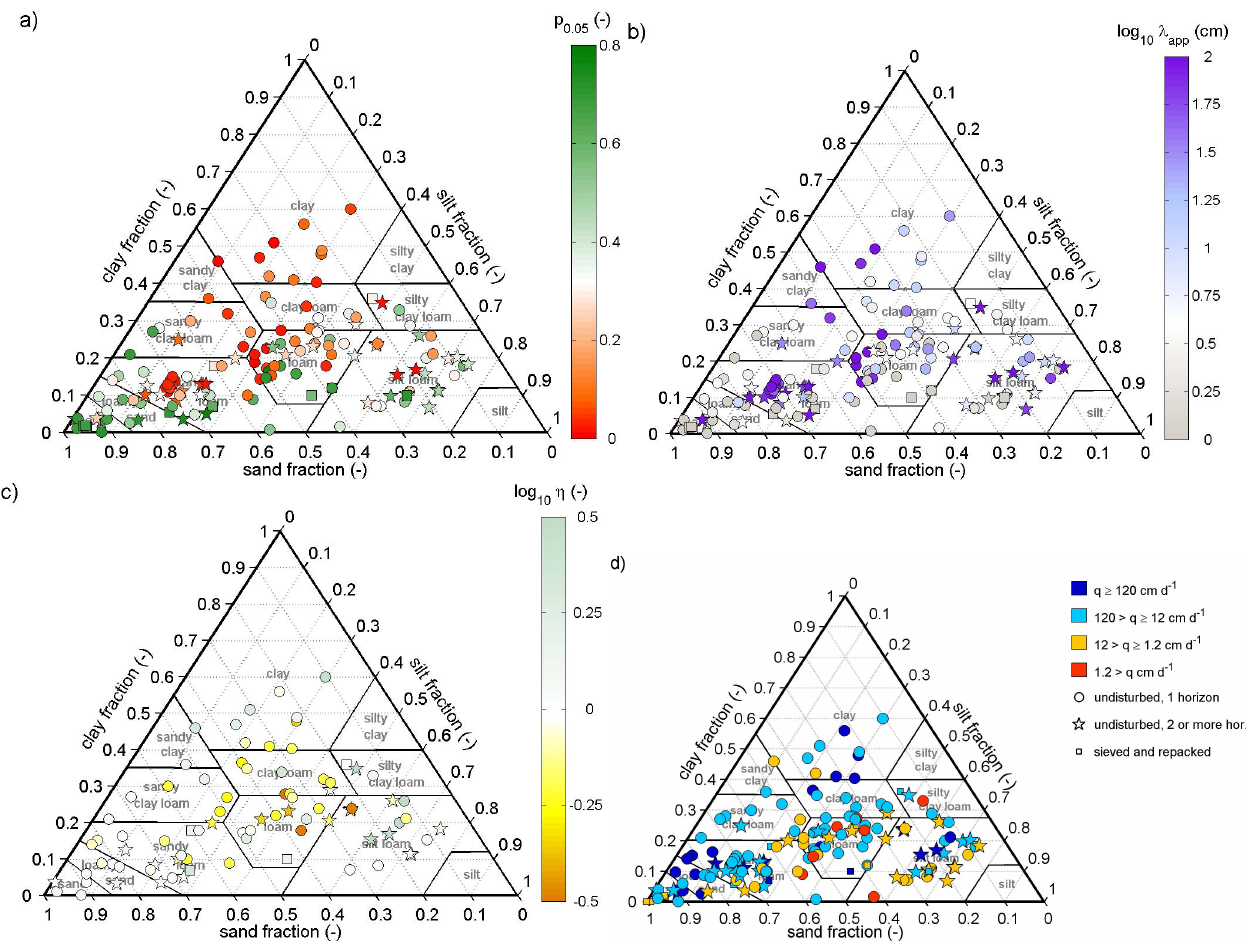
Fig. 9. The (a) normalized 5%-arrival time, p 0 . 05 ; (b) apparent dispersivity, λ app ; (c) the piston-flow to transport velocity ratio, η ; and (d) the water flux classes corresponding to the considered BTC